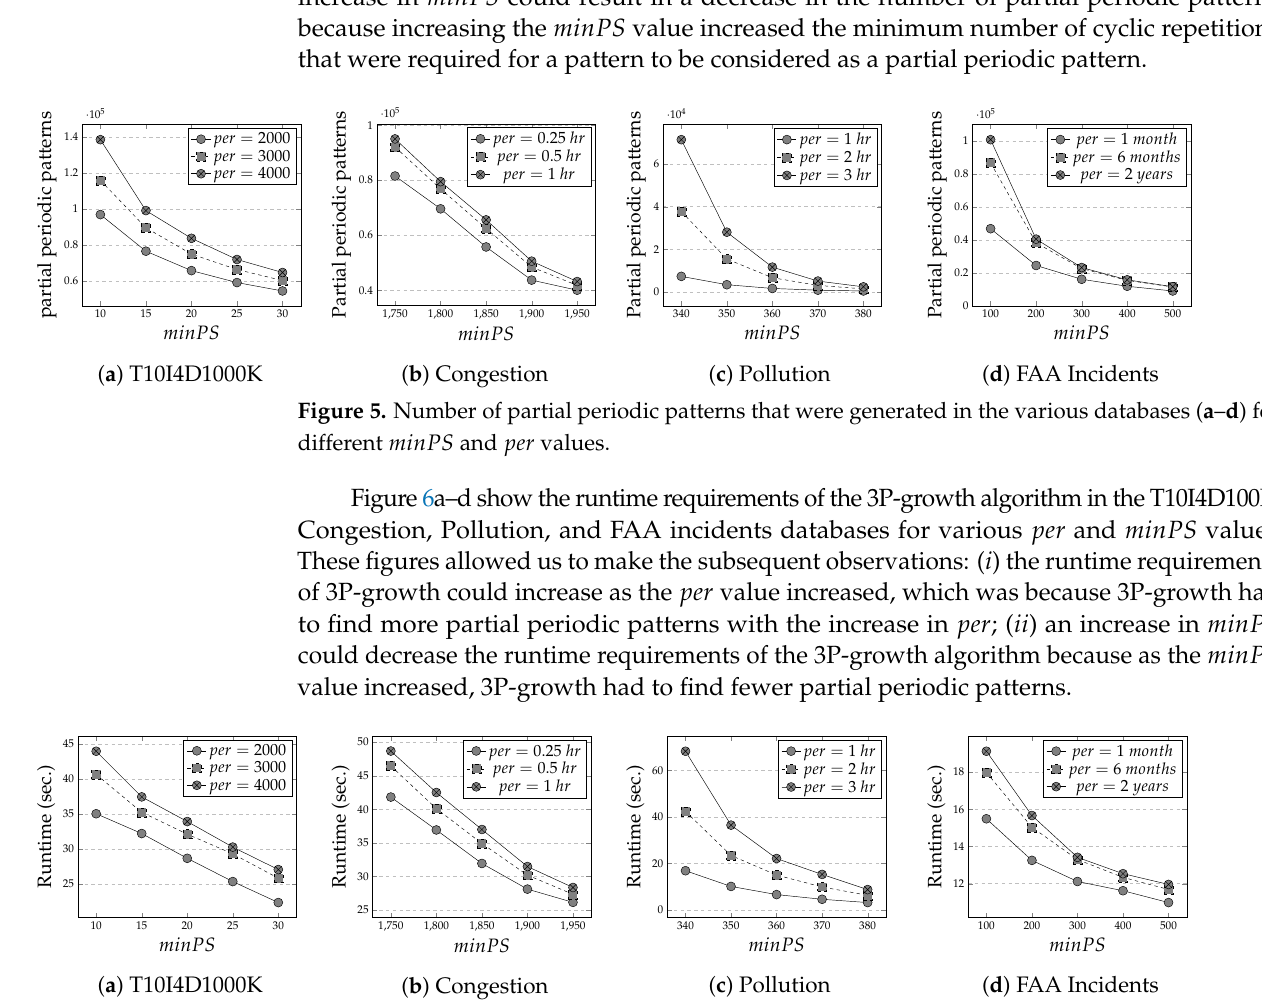
Figure 6. Runtime requirements of the 3P-growth algorithm in the various databases ( a – d ) for different minPS and per